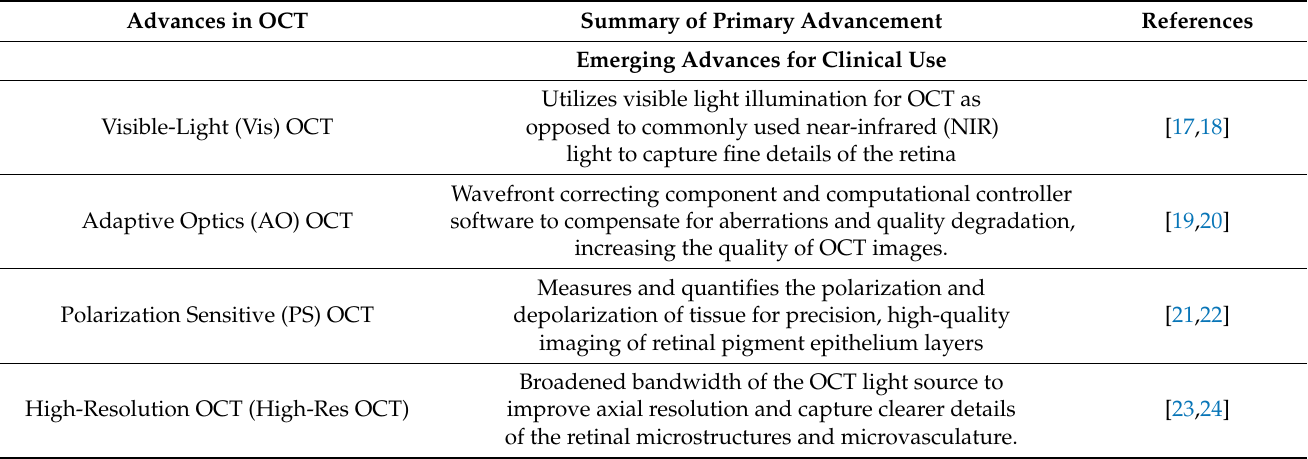
Table 1. Advances in optical coherence tomography (OCT) imaging technology and techniques. Advances are categorized into emerging advances for clinical use, advances for basic science/research, and recent advances in available